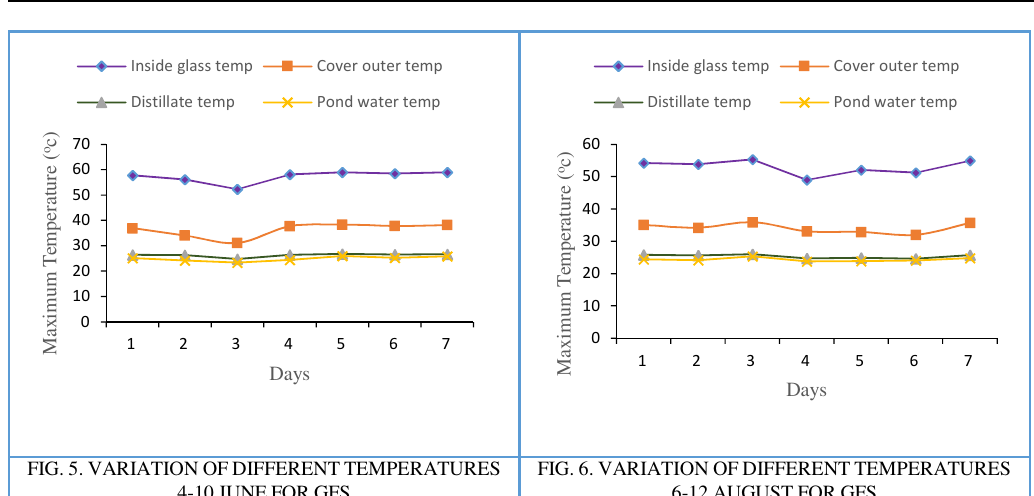
FIG. 6. VARIATION OF DIFFERENT TEMPERATURES 6-12 AUGUST FOR